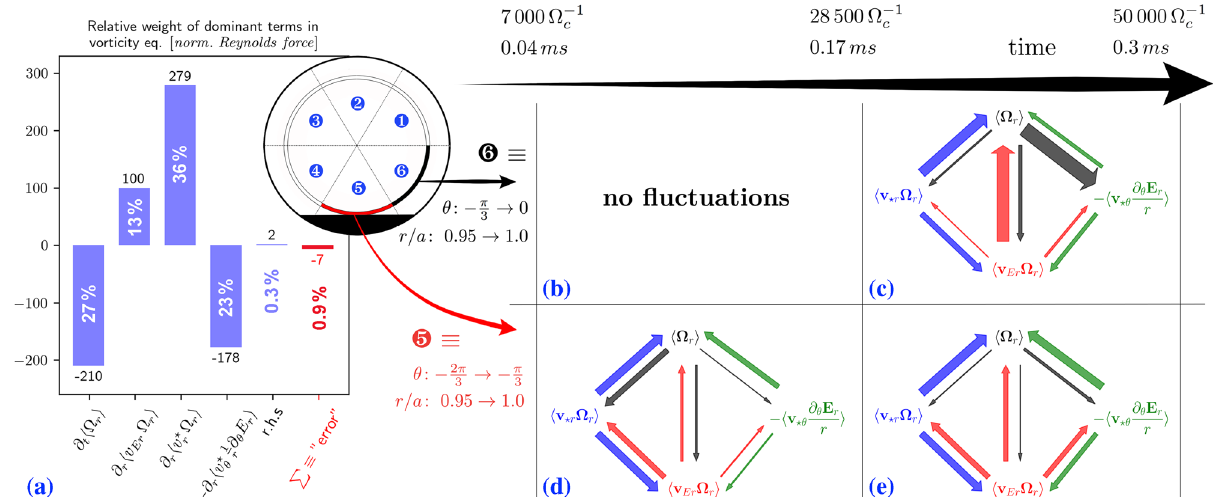
Fig. 5 Accurate vorticity balance allows investigation of causality in transport barrier build-up. Causal interactions are investigated in the early stages of barrier build-up (initial 0.3ms, or 50 ; 000 Ω (cid:3) 1 ci ), between 0.95 ≤ r / a ≤ 1.0 where limiter-induced fl uctuations are borne. ( a ): Precise test of vorticity balance through systematic computation of all terms in Eqs. (7) and (8). Their relative magnitudes are estimated through radial (0.95 ≤ r / a ≤ 1.0), toroidal (0 ≤ θ ≤ 2 π ), poloidal (0 ≤ φ ≤ π /5) and temporal (0 ≤ t Ω ci ≤ 50,000) averaging. Their algebraic sum is displayed as “ error ” (value − 7 corresponds to 0.9% error). All terms in Eq. (8) are individually small, with r.h.s denoting their sum. ( b through e ): the outer corona (0.95 ≤ r / a ≤ 1.0) of plasma volume is divided in six areas; we especially focus on areas ❺ ( − 2 π /3 ≤ θ ≤ − π /3), centred about the limiter where the radial electric fi eld well originates and area ❻ ( − π /3 ≤ θ ≤ 0) into which turbulence later spreads. Dominant information transfer from systematic pairwise TE computations is diagrammatically represented for areas ❺ and ❻ , during two time intervals. During Δ t 1 (0.04 ms to 0.17 ms), turbulence is con fi ned to area ❺ ( d ) and other regions are stable ( b ). During Δ t 2 (0.17 ms to 0.3 ms), fl uctuations have contaminated area ❻ ( c ) whilst keep being produced in area ❺ ( e ). Arrows indicate the direction of information fl ow and their respective thickness is proportional to the amount of information actually